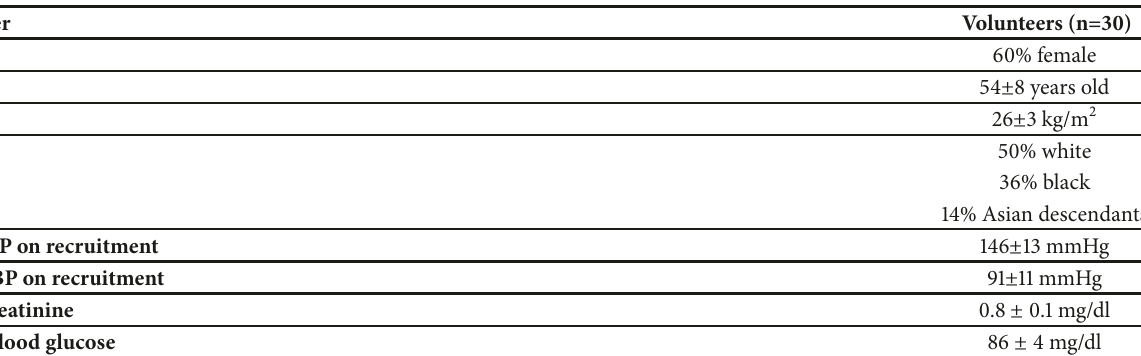
Table 1: D emographic and la b oratory data. BMI = body mass index; SBP= systolic blood pressure; DBP= diastolic blood